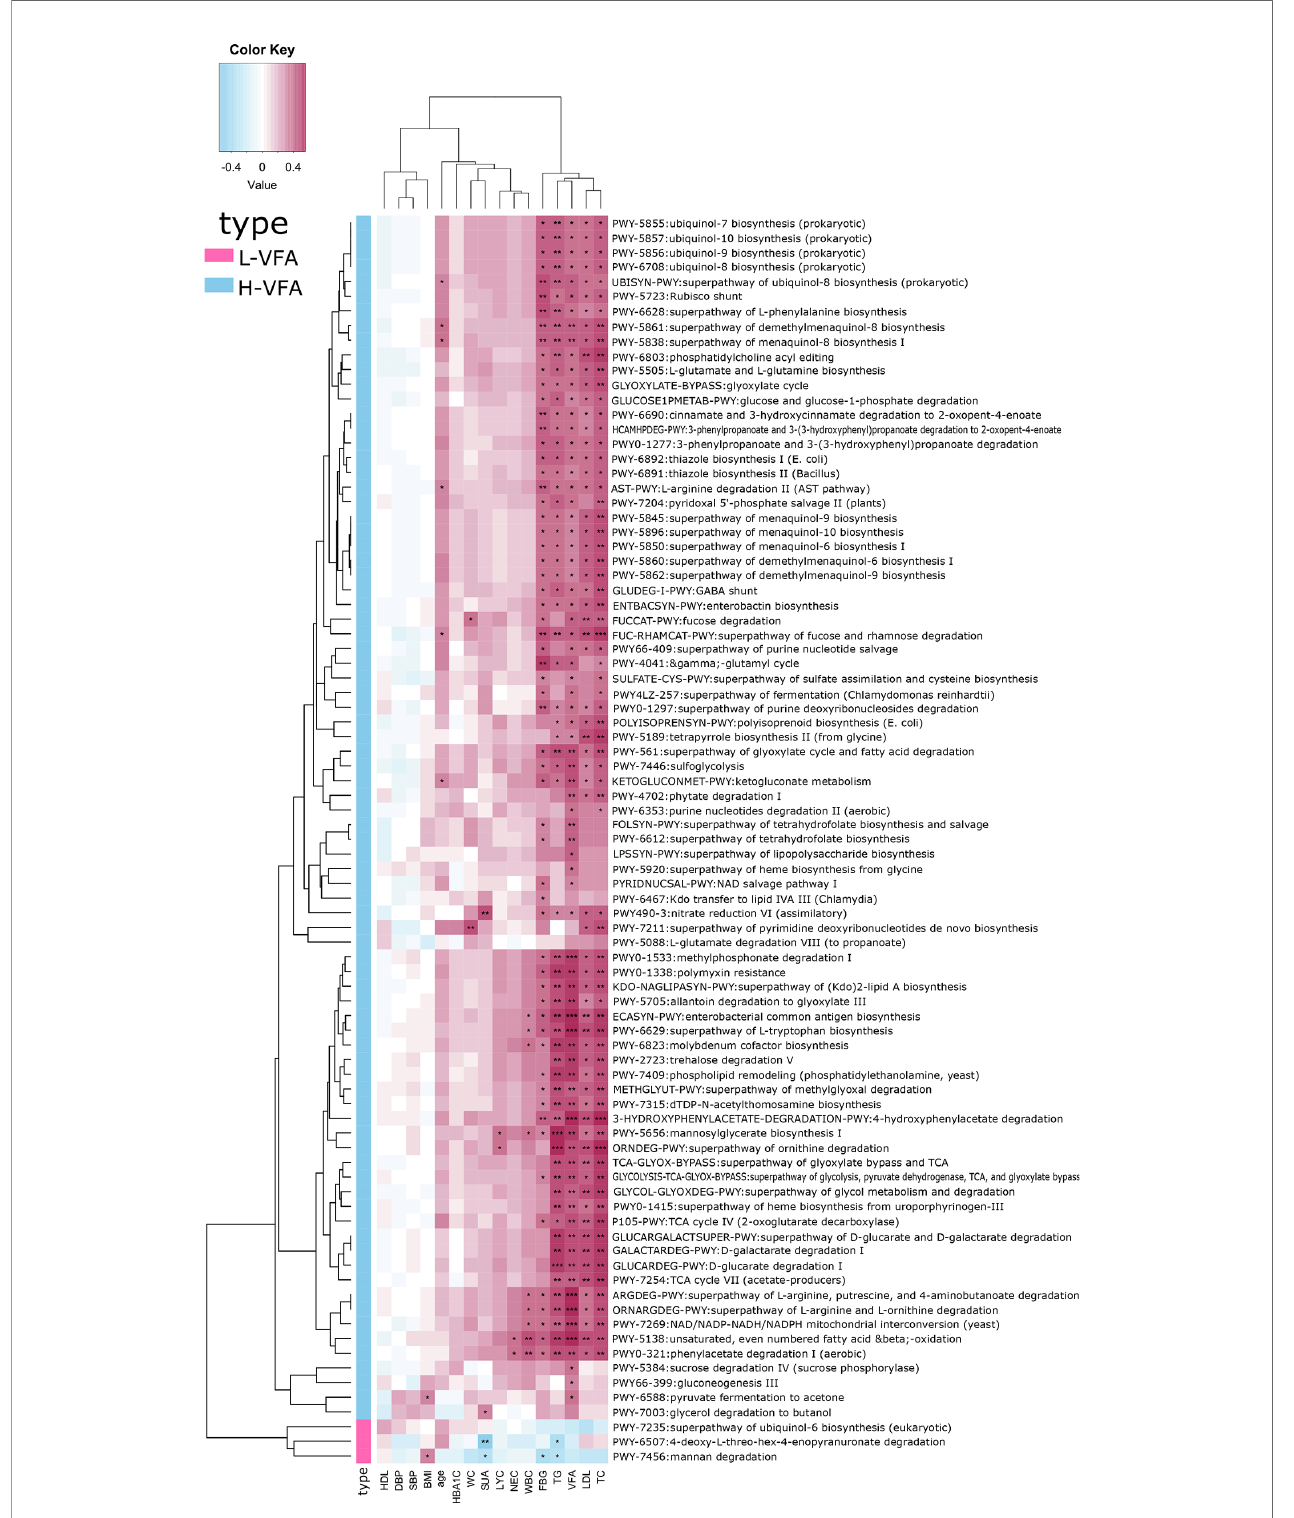
FIGURE 4 | Association between functional shifts in the microbiome characteristics and clinical characteristics. Cell color indicates the correlation type (pink: positive, blue: negative). *, **, and *** denote p < 0.05, p < 0.01, and p < 0.001, respectively. In the H-VFA group, almost all the pathways were positively correlated with the VFA. Only one pathway (PWY-6588) was positively correlated with the BMI, and two pathways (FUCCAT-PWY, PWY-7211) were positively correlated with the WC.